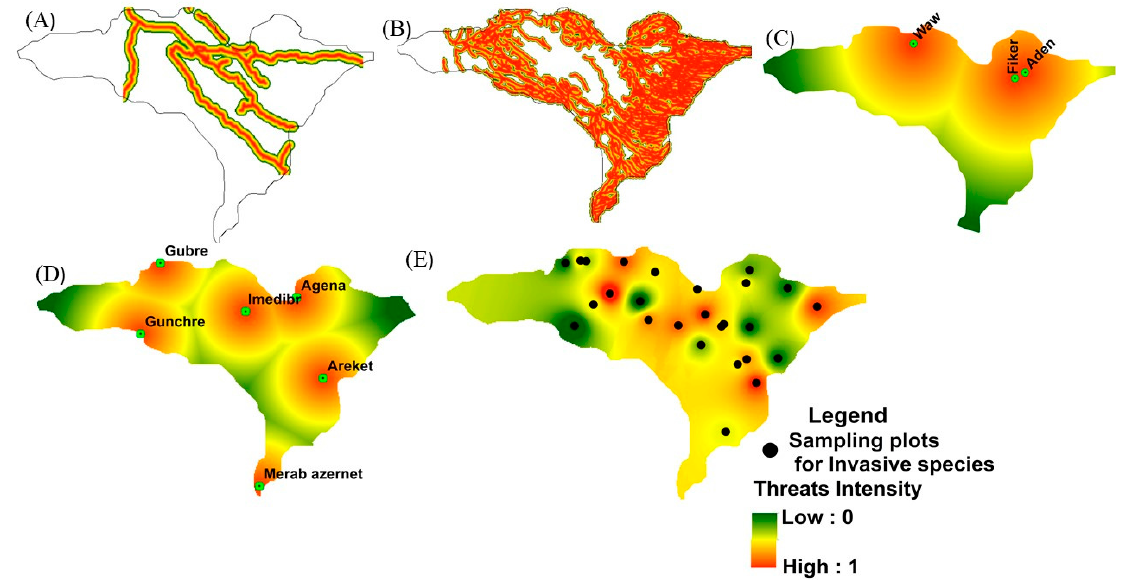
Figure 6. Spatial distribution maps of ( A ) the paved road system, ( B ) the unpaved road system, ( C ) water abstraction, ( D ) pollution, and ( E ) invasive species.